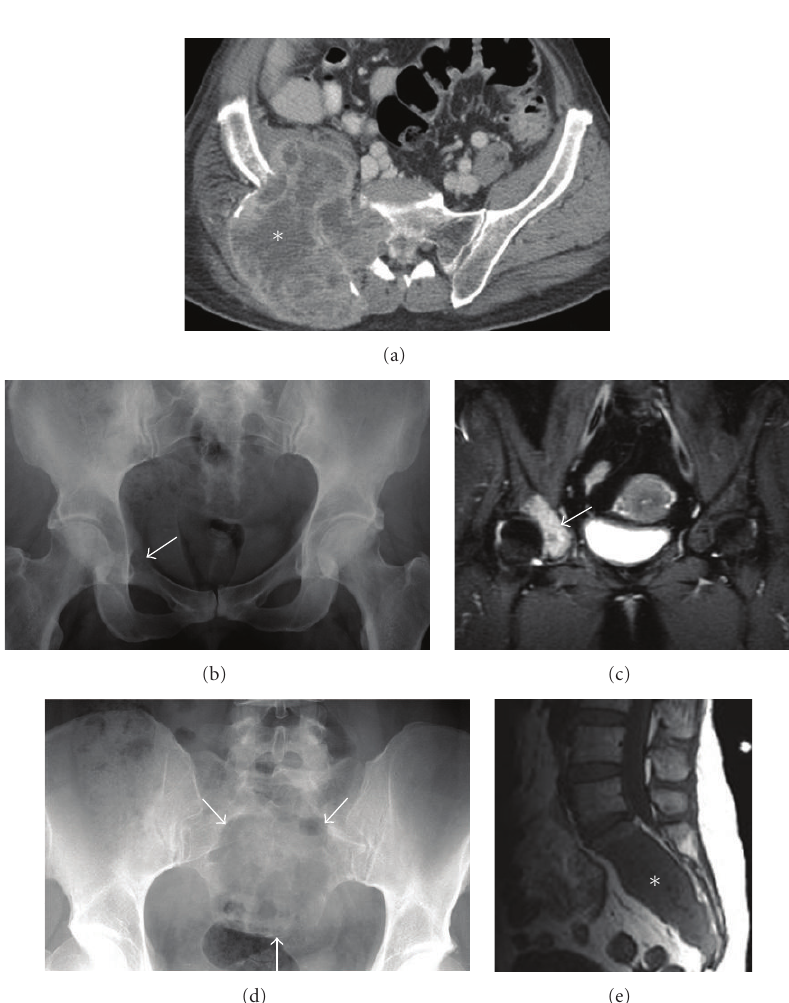
Figure 4: Metastasis. A 58-year-old male presents with a short history of right hip pain and a remote history of primary renal cell carcinoma diagnosed with metastases. Axial post-contrast CT of the pelvis (a) demonstrates a large destructive expansile necrotic mass (asterisk), arising within the right ilium and extending into the right sacrum. Two di ff erent patients with breast cancer metastasis to the acetabulum (b) and (c) and to the sacrum (d) and (e). These lytic lesions can be di ffi cult to identify on plain films (b) and (d) more easily appreciated on coronal STIR (c) and sagittal T1 (e) MRI. Note the destruction of arcuate lines by the sacral lesion; destruction of the subarticular cortex, asymmetric density of the right acetabulum, and fuzziness of the right iliopectineal line by the acetabular